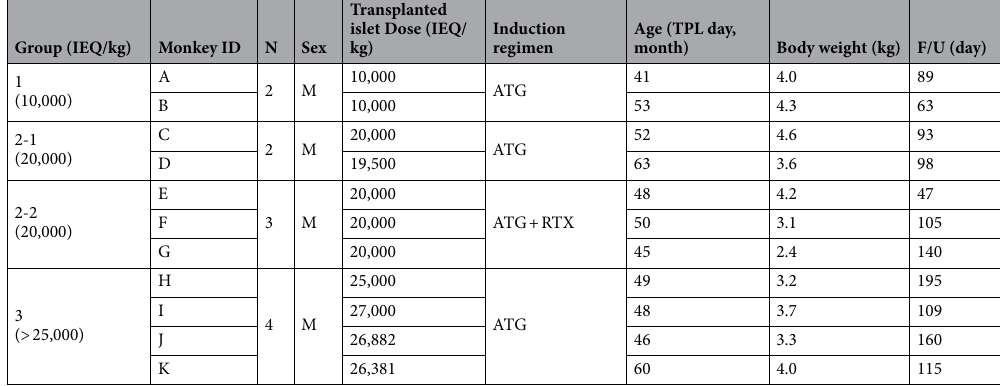
Table 1. Transplantation information for the eleven experimental cynomolgus monkeys. IEQ Islet equivalent number, ATG rabbit anti-thymocyte globulin, RTX rituximab, TPL Transplantation, F/U Follow-up day after